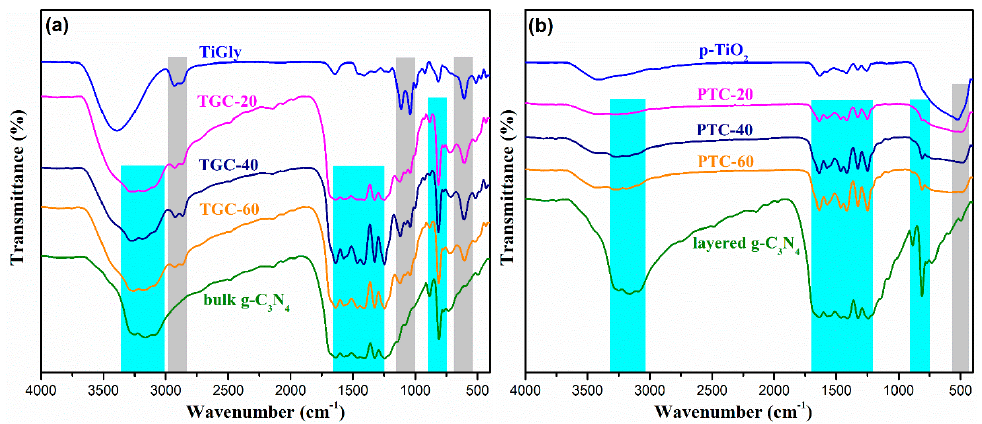
Figure 4. ( a ) FT-IR patterns of bulk g-C 3 N 4 , TiGly and TGC- x before calcination; ( b ) FT-IR patterns of layered g-C 3 N 4 , p-TiO 2 and PTC- x .